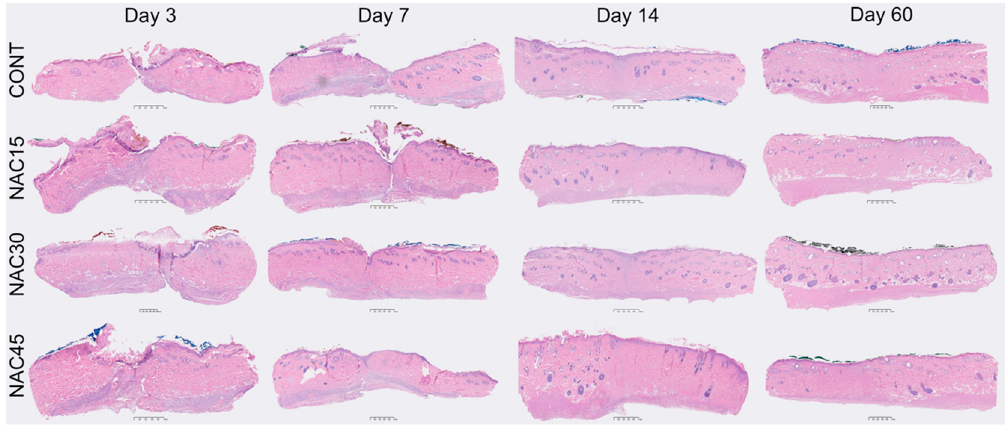
Figure 4. HE sections of representative samples from each group (NAC15, NAC30, NAC45, and CONT) at each harvest point. 1mm scale bar provided under each sample.